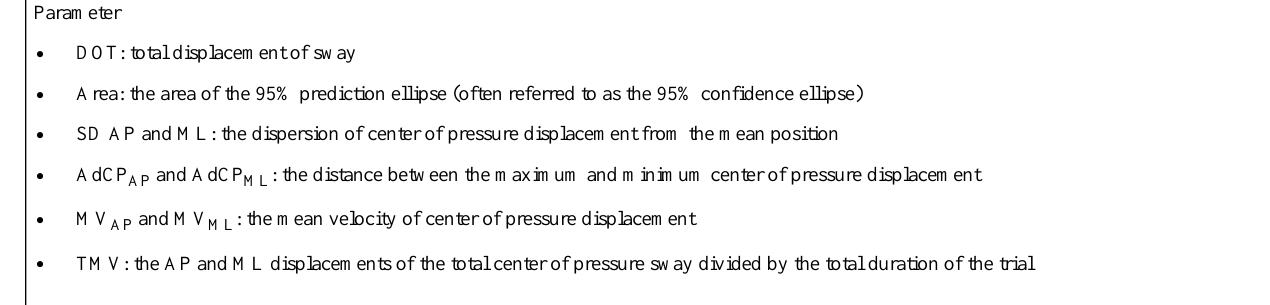
between the Wii Balance Board and studied variables. Spearman correlation coefficients were computed between variables obtained from the force place and Wii Balance Board.